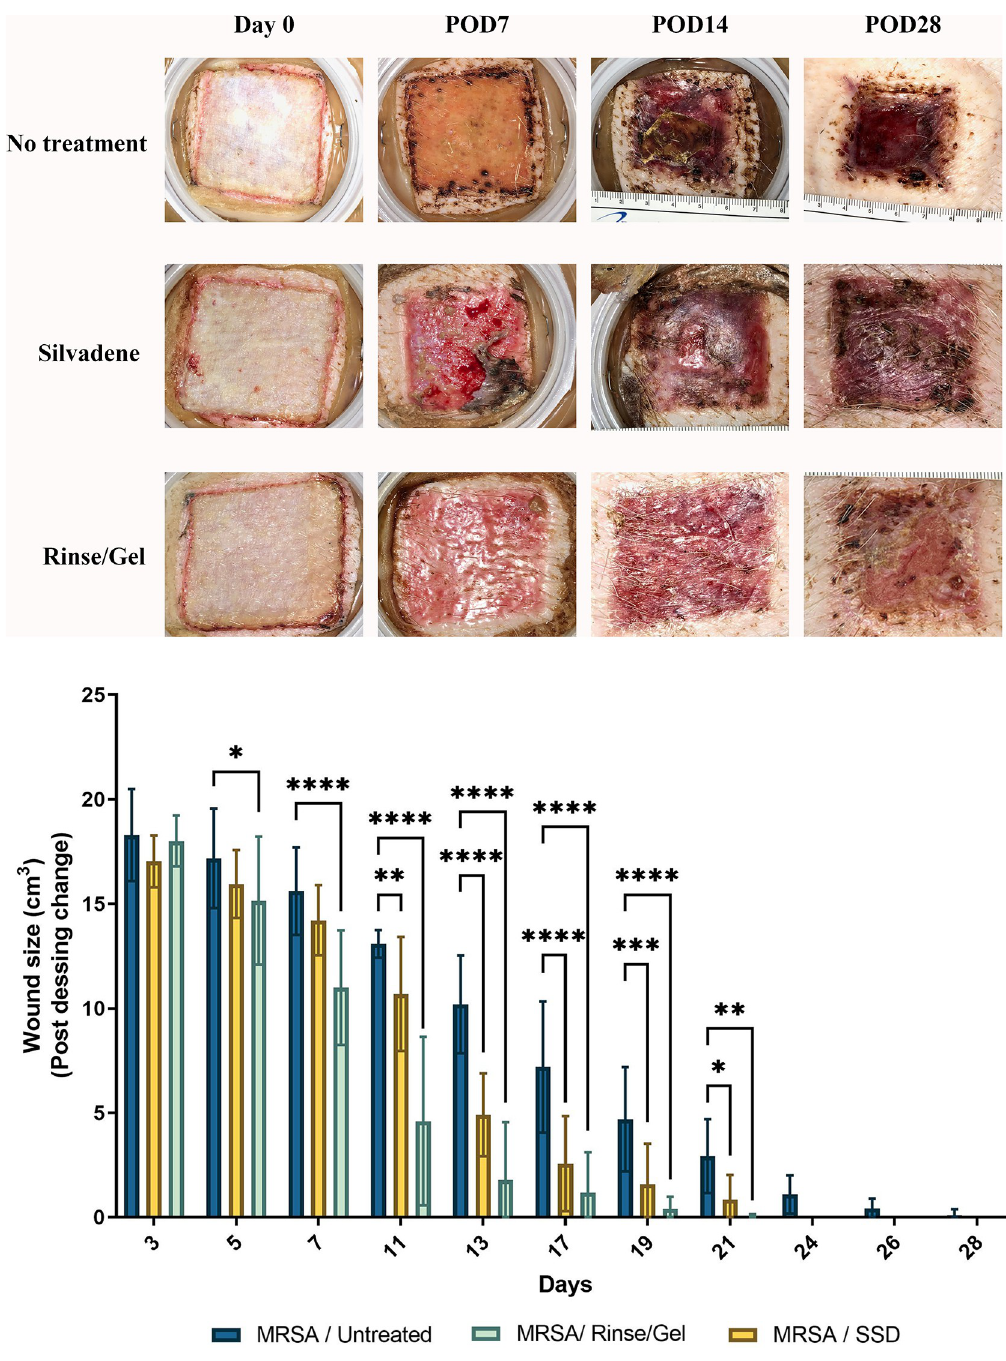
Fig 5. A) Representative images of MRSA-infected PTBW’s treated with SSD and wound rinse and wound gel compared to the untreated burns over 28 days, post dressing change. Wound healing progression was imaged at the time of the post- dressing changes, following the initial injury. The rinse/gel treatment facilitates complete tissue re-epithelialization in infected PTBW by 28 days compared to silver sulfadiazine (SSD) treated wounds that show healthy granulation, but only a thin layer of new epithelium. POD- Post dressing change. Wound dimensions- 4X4 cm. B) Rate of wound re-epithelialization post dressing change over 0–28-day pigs. Rinse/gel treatment consistently resulted in faster tissue re- epithelialization over time ( ���� , P < 0.0001; ��� , P < 0 � 001) compared to the SSD treated and untreated controls,